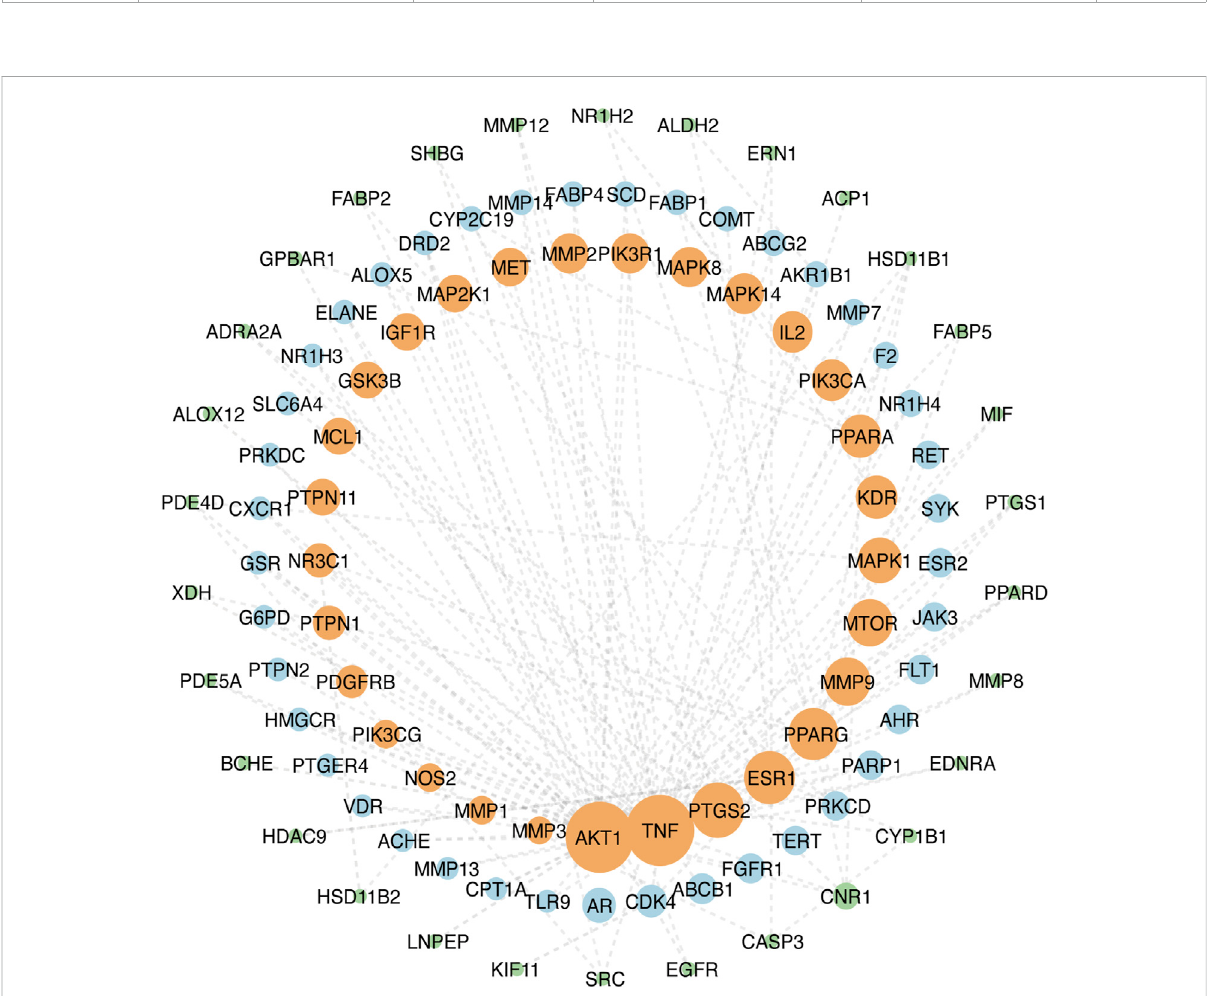
FIGURE 4 PPI network of ZZO anti-DU. Node size re fl ects node degree: bigger size means the larger degree value.